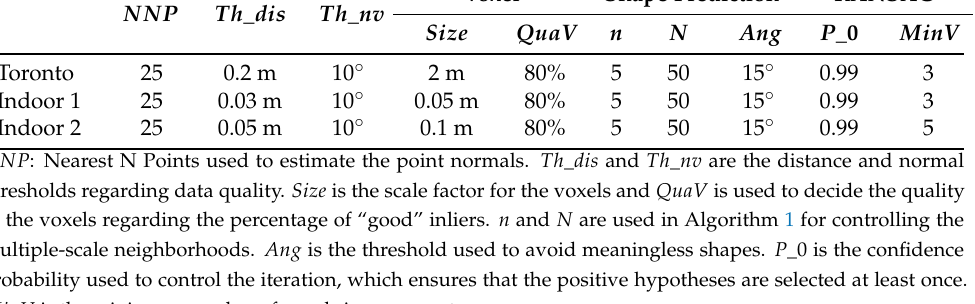
Table 3. The parameters used in the experiments.